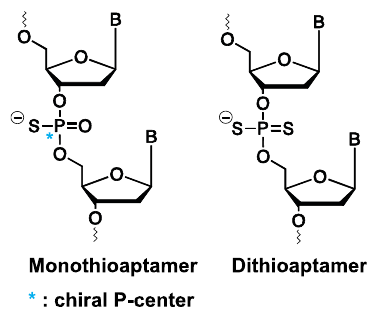
Figure 11. Structure of mono- and dithioaptamers.